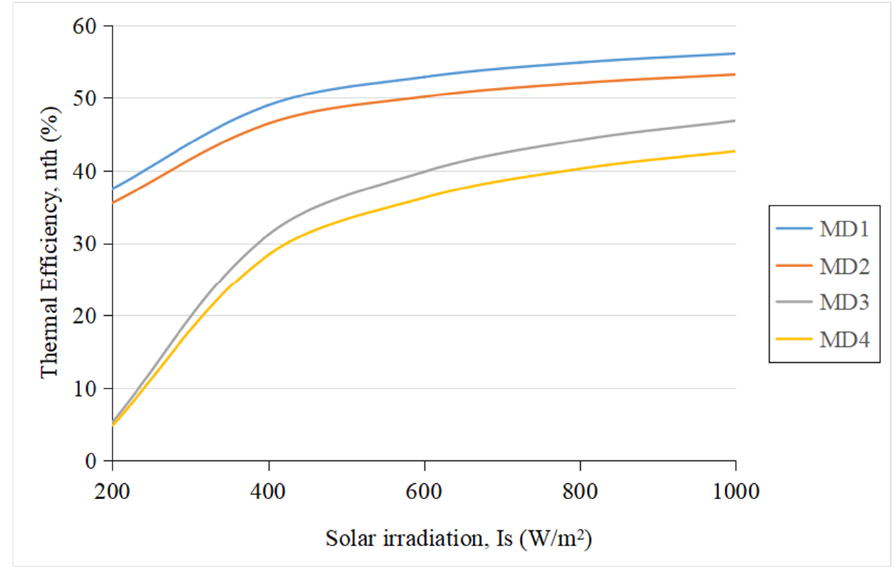
Figure 17. Thermal efficiency of four PV/T module models when changing solar radiation intensity.